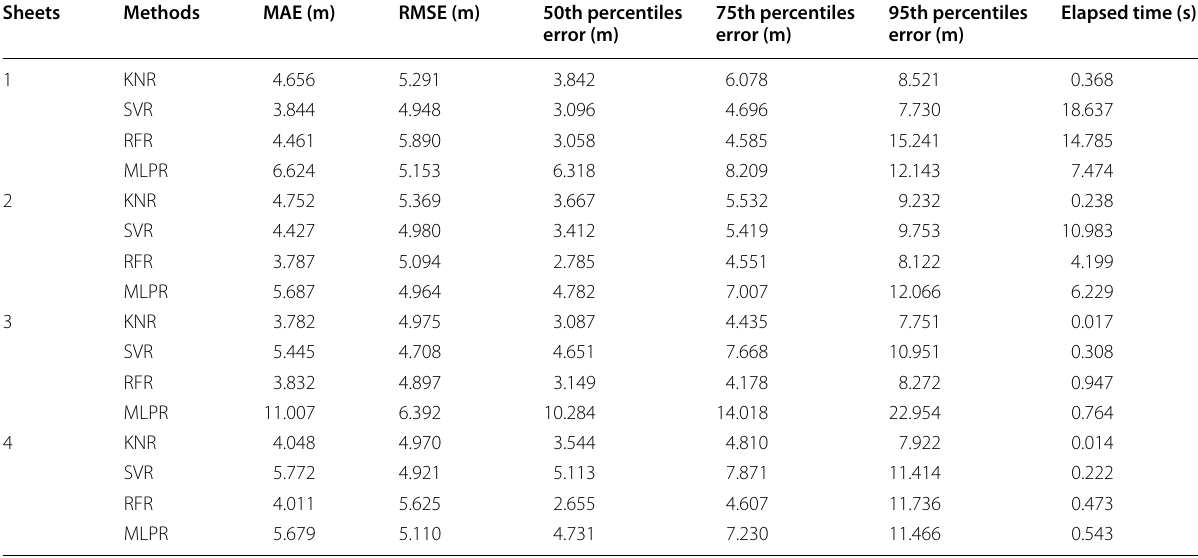
line with circles indicates the CDF of the KNR method. It is always higher than the other lines. Considering Table 13 and Fig. 7 together, the KNR method achieves